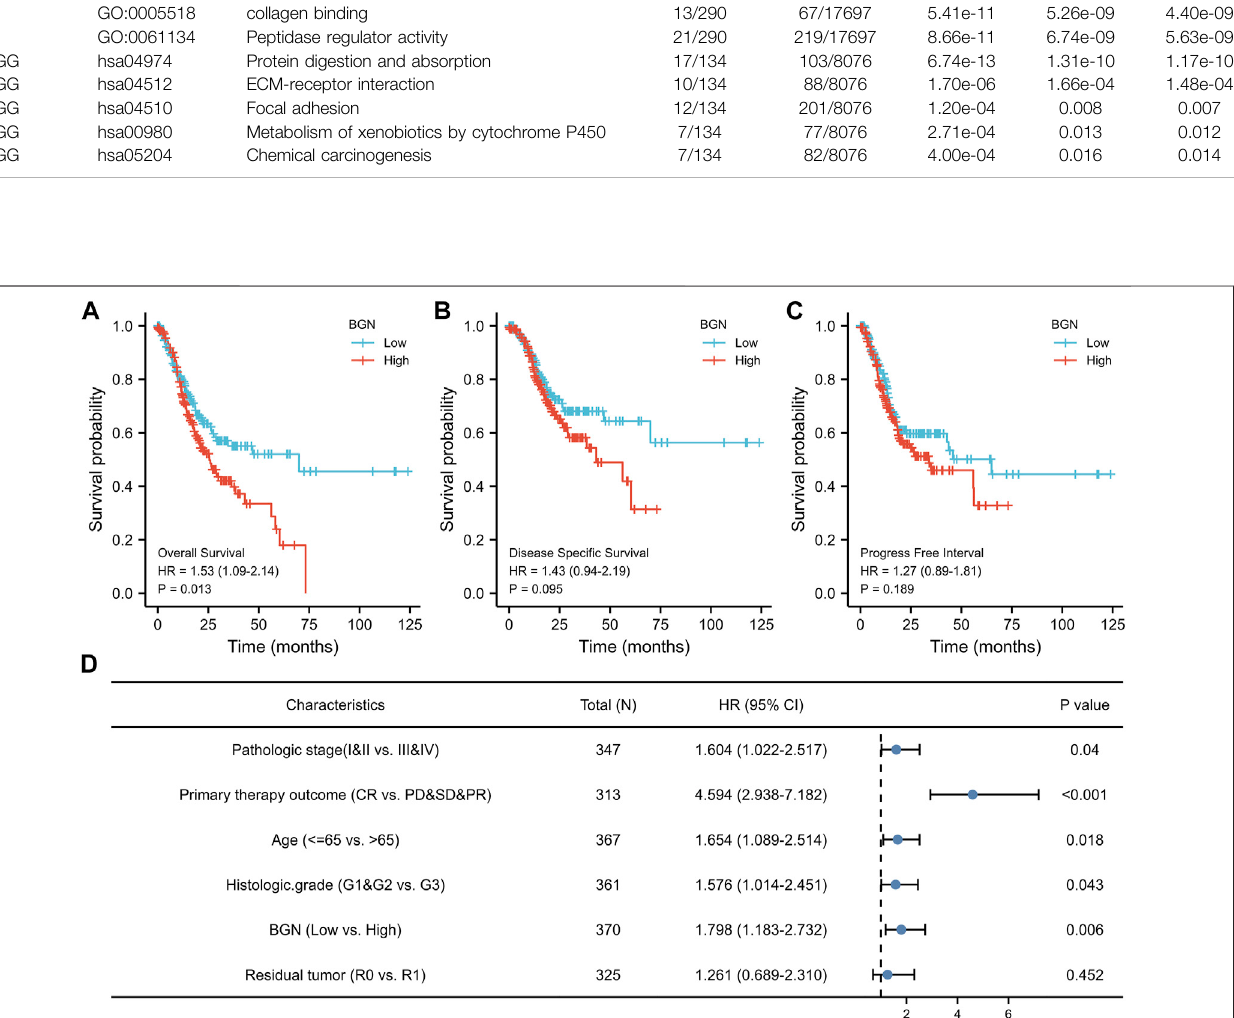
Frontiers in Genetics |